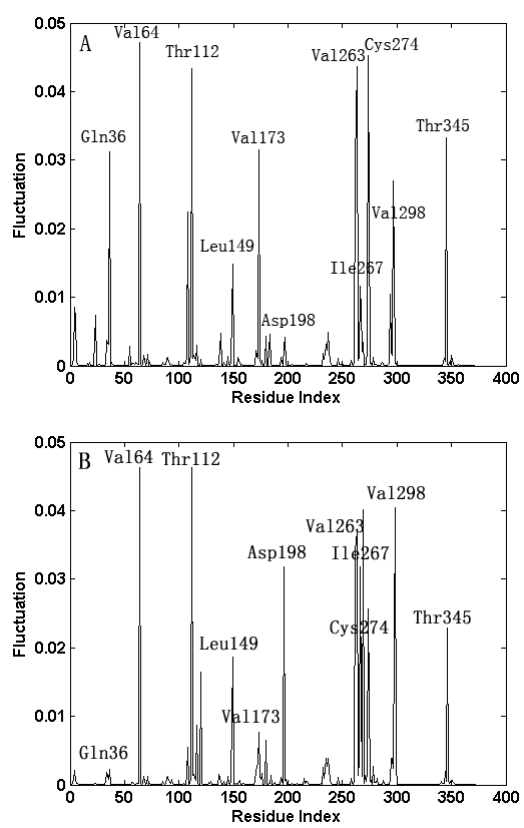
Figure 7. ( A , B ) The mode shape as the average of the eight fastest modes for the open-apo and closed-holo structure of L - Mt AlaDH. The same key residue clusters identified by our method are marked by the residue name in the